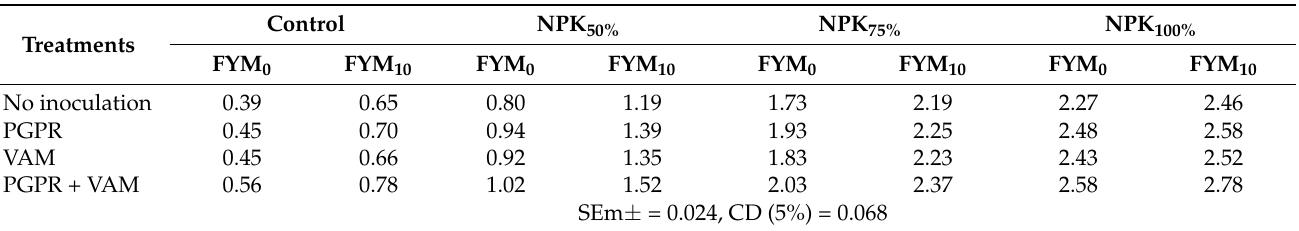
Prices—wheat grain = 1250 ₹ q − 1 (Department of Agriculture and Cooperation, Directorate of Economics and Statistics), wheat straw = 300 ₹ q − 1 (Local Market). Table 8. Interaction effect of fertility levels, FYM, and bio-inoculants on the economics (B:C ratio) of wheat (mean of two years).